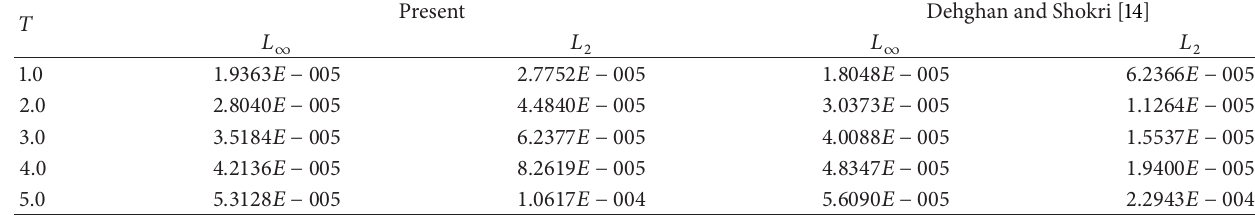
Table 4: Error norms at different time stages for equation 𝑢 𝑡 + 6𝑢𝑢 𝑥 + 𝑢 𝑥𝑥𝑥 = 0 , with 𝑢(𝑥, 0) = (𝑐/2) sech 2 ((√𝑐/2)𝑥 − 7),𝑐 = 0.5 . 𝑑𝑥 = 0.2 , and 𝑑𝑡 = 0.1 × 𝑑𝑥 3 .